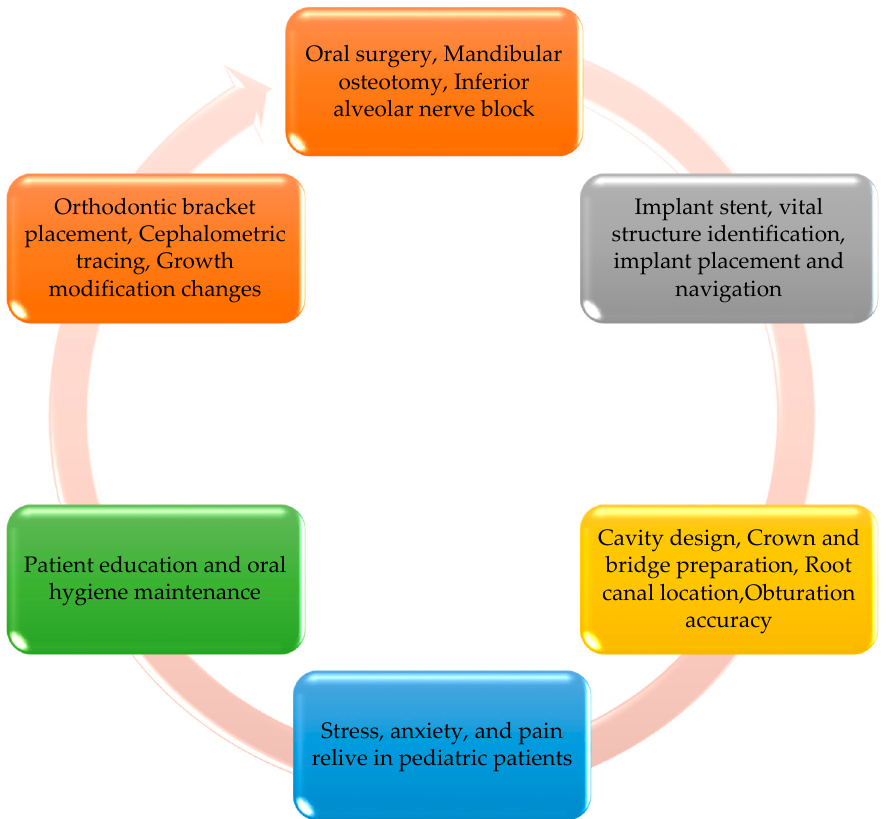
Figure 1. Use of virtual /augmented reality in dentistry.